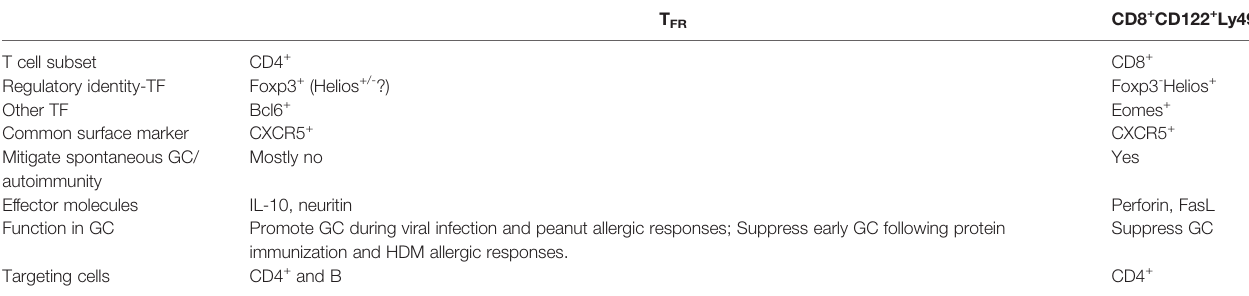
TABLE 2 | T FR and CD8 + CD122 + Ly49 +